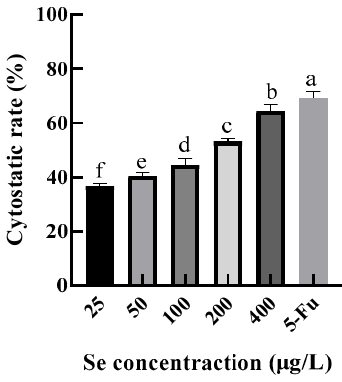
Figure 11. Inhibitory effect of selenium-enriched rape protein on HepG2 cells. Notes: means with different lower-case letter differed significantly at p < 0.05.